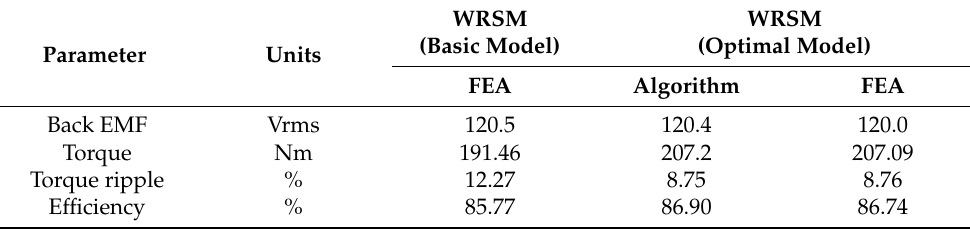
Figure 13. Torque comparison. Table 4. Basic and optimal models: performance